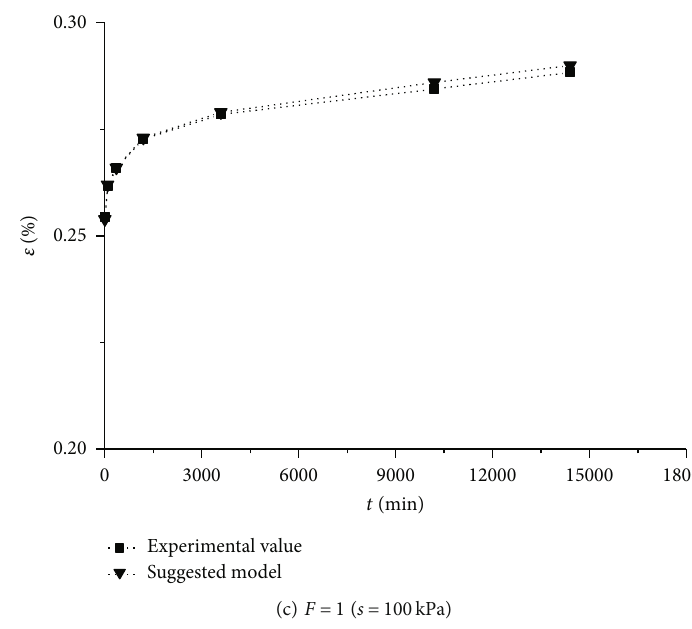
Figure 12: Model validation ( net meanpressure = 100kPa